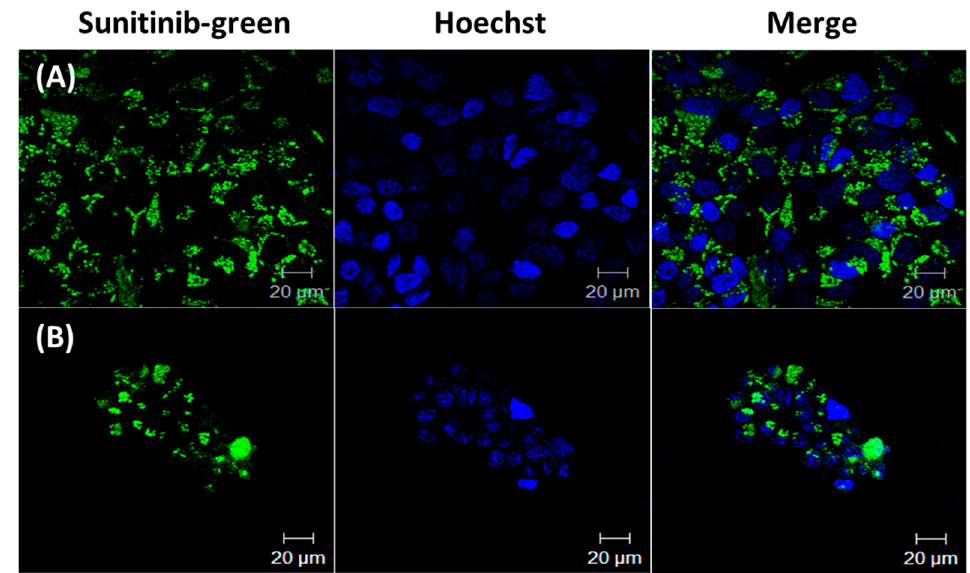
Figure 4. Confocal microscope images of cellular uptake of Sunitinib micelles ( A ) and SN- 38/Sunitinib micelles ( B ). HCT-116 cells were treated at 37 °C for 24